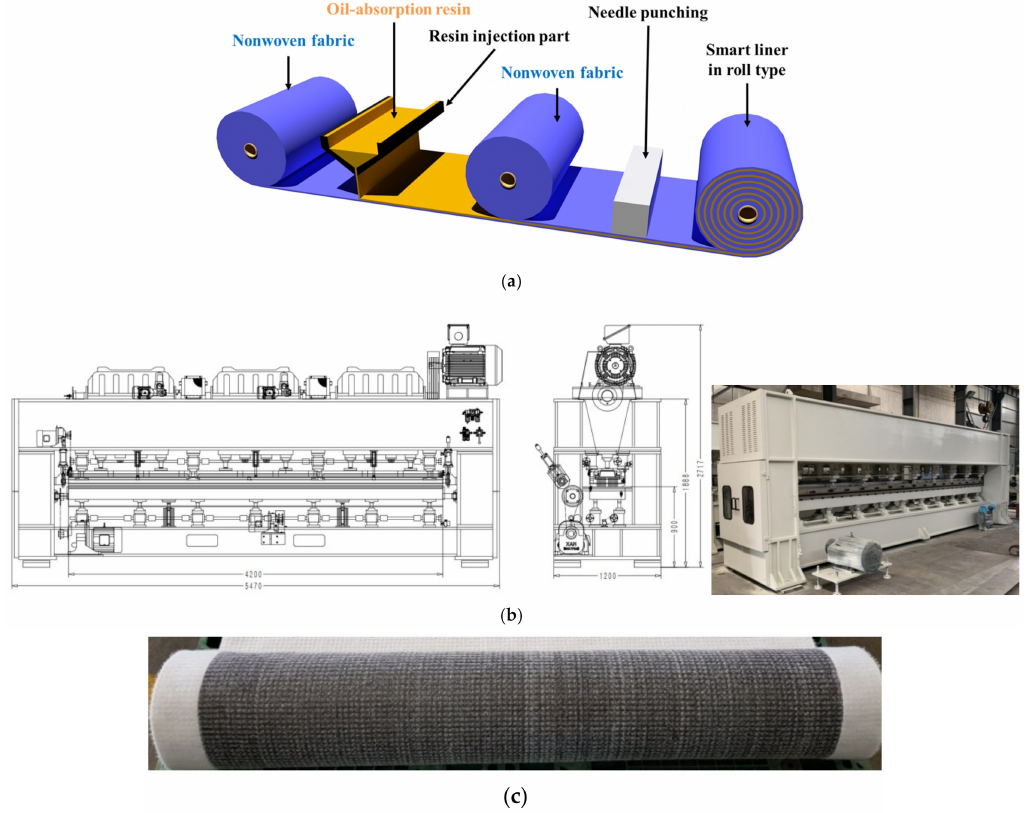
Figure 3. Manufacture of the smart liner: ( a ) concept diagram, ( b ) design drawings, actual picture of the manufacture equipment, and ( c ) sample of the smart liner produced in a roll